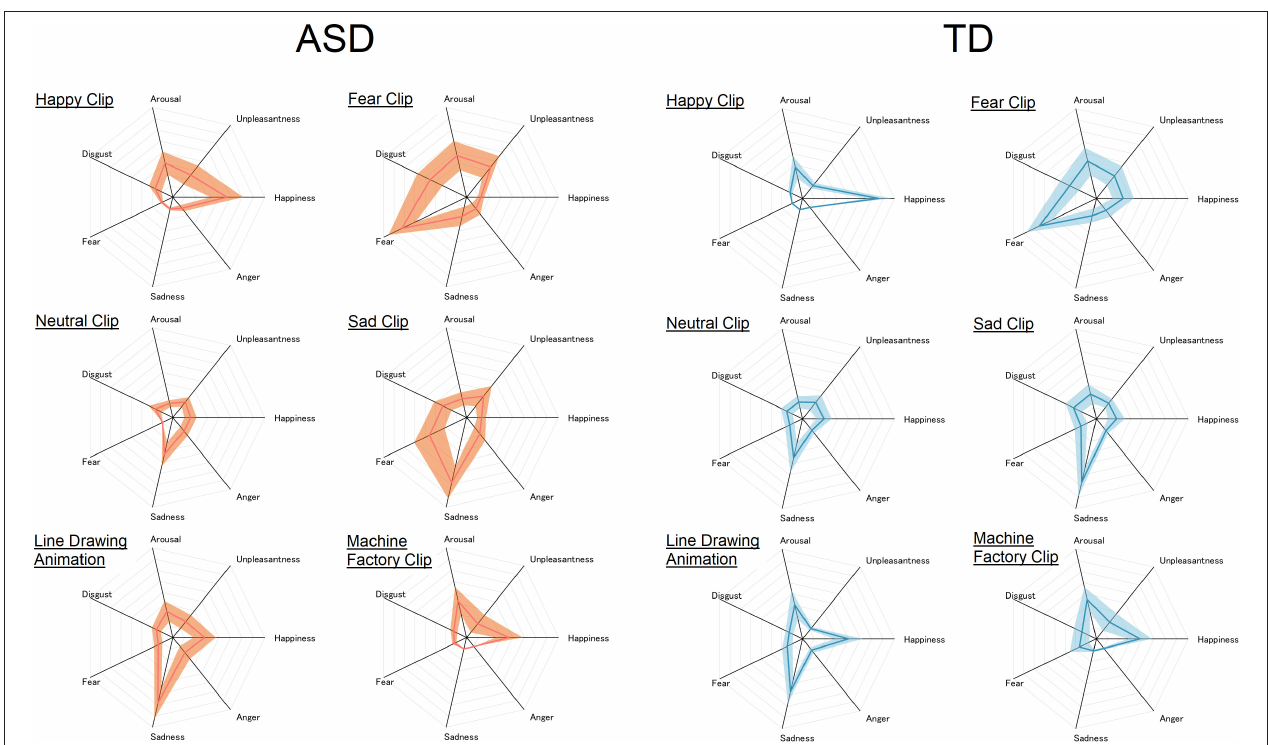
FIGURE 2 | Subjective rating of each emotional state given to each of the six video clips in the ASD (left) and TD (right) groups. The center of the radar chart is zero, and the outermost point of each axis is eight. The thick line and the width of the shaded area along each axis represent mean and standard deviation, respectively.